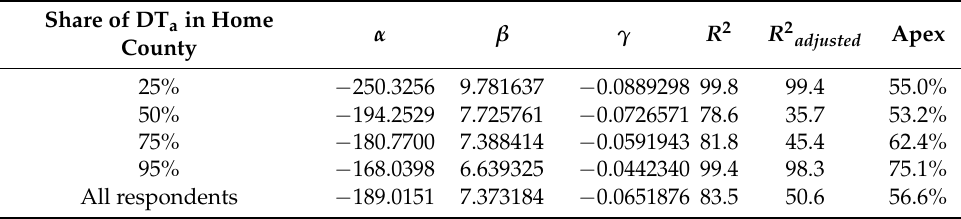
Table 5. Parameters of function (3) for estimating WTP for different shares of deciduous trees (DT a ). Share of DT a in